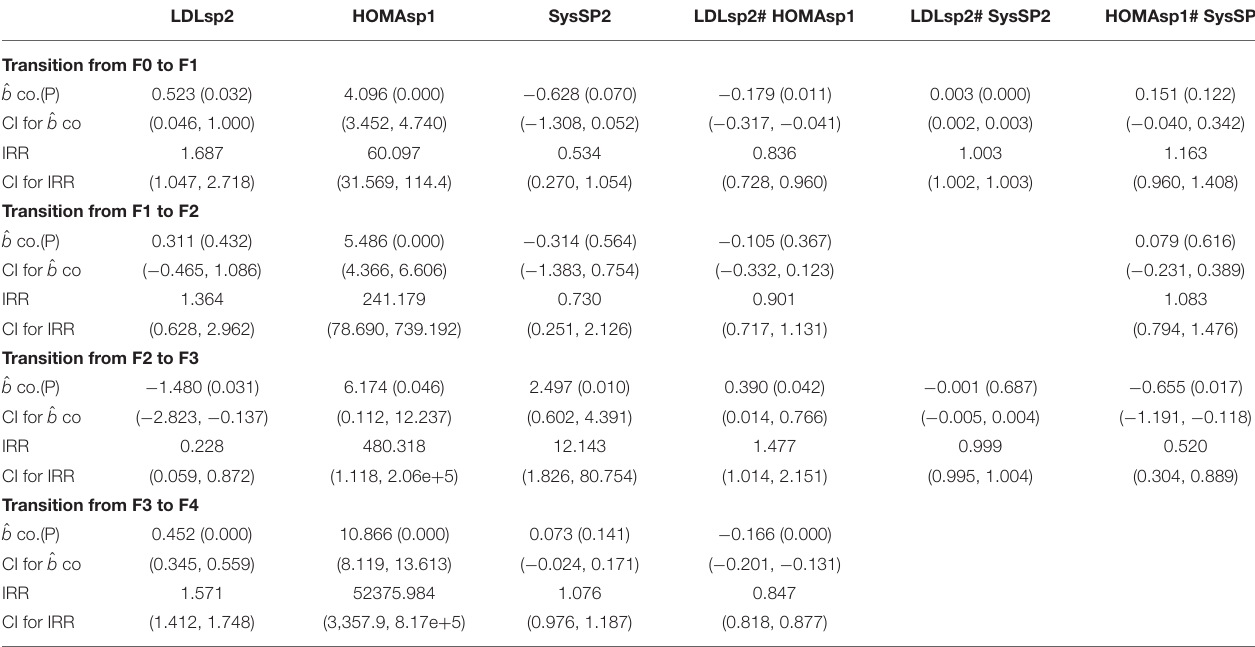
TABLE 4 | Parameters for each